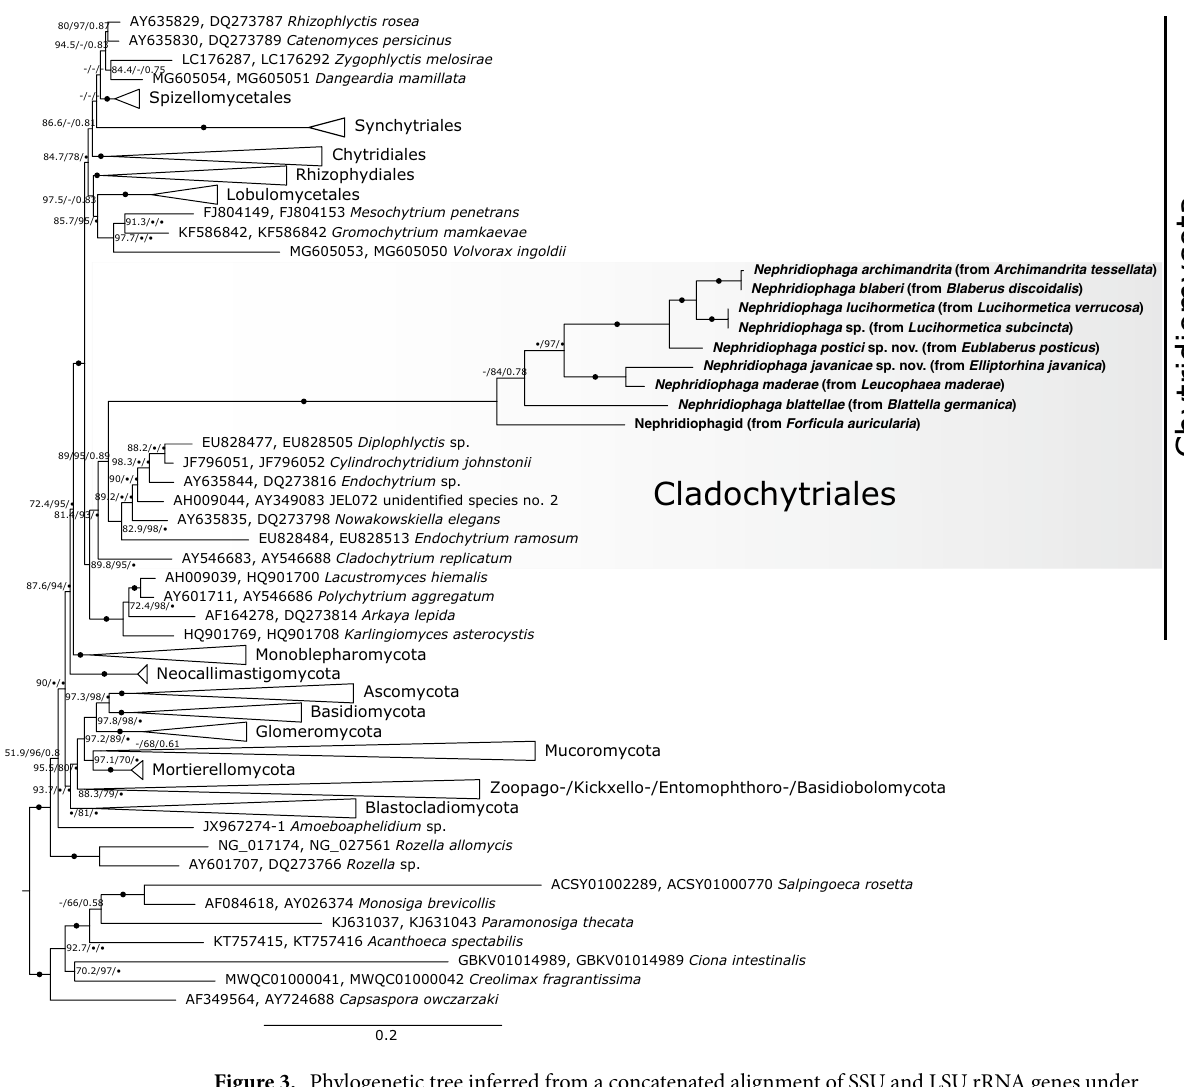
Figure 3. Phylogenetic tree inferred from a concatenated alignment of SSU and LSU rRNA genes under the GTR + F + I + G4 model. Branch support is given by SH-aLRT/UFBoot2/Bayesian posterior probabilities. Black circles indicate support values ≥ 99% or ≥ 0.9, and dashes indicate values < 50% or < 0.5. Black circles at branches show ≥ 99% and ≥ 0.9 support in all analyses. Sequences obtained in this study are marked in bold. Note, for nephridiophagids obtained from Lucihormetica spp. and Archimandrita tessellata only SSU rRNA gene sequences have been used for tree inference. See Supplementary Data for taxa of collapsed